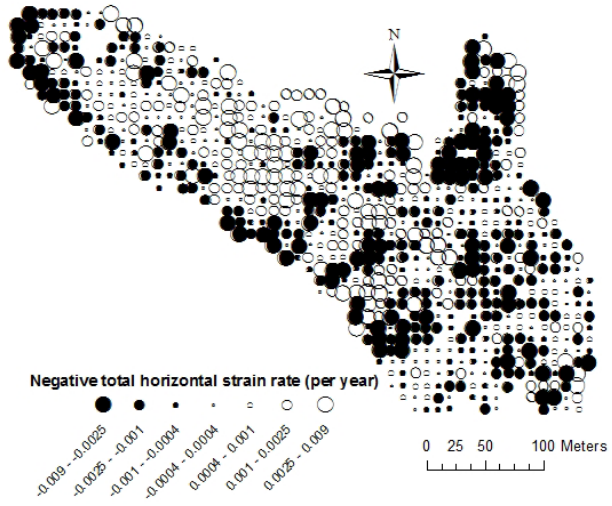
Figure 7. The negative sum of the horizontal strain rates (assumed to be equal to the vertical strain rate for an incompressible medium) for the Muragl rockglacier.